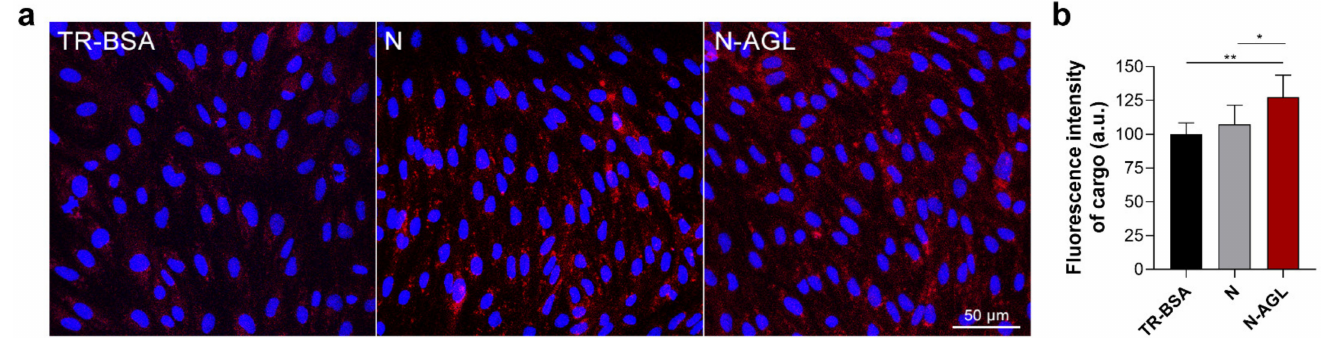
Figure 4. ( a ) Confocal microscopy images of cultured RBECs incubated with Texas red-labeled albumin (TR-BSA; red fluorescence), non-targeted (N) or ascorbic acid-glutathione-leucine-targeted (N-AGL) nanoparticles. Cell nuclei are shown in blue. Scale bar: 50 µ m. ( b ) Fluorescence intensity evaluation of TR-BSA, N or N-AGL treated cells. (24 h, 37 ◦ C). Values presented are means ± SD and are given as arbitrary units (a.u.), shown as percentage of the TR-BSA group. Statistical analysis: one-way ANOVA followed by Dunnett’s posttest; * p < 0.05, ** p < 0.01, compared to the TR-BSA group; n = 6.